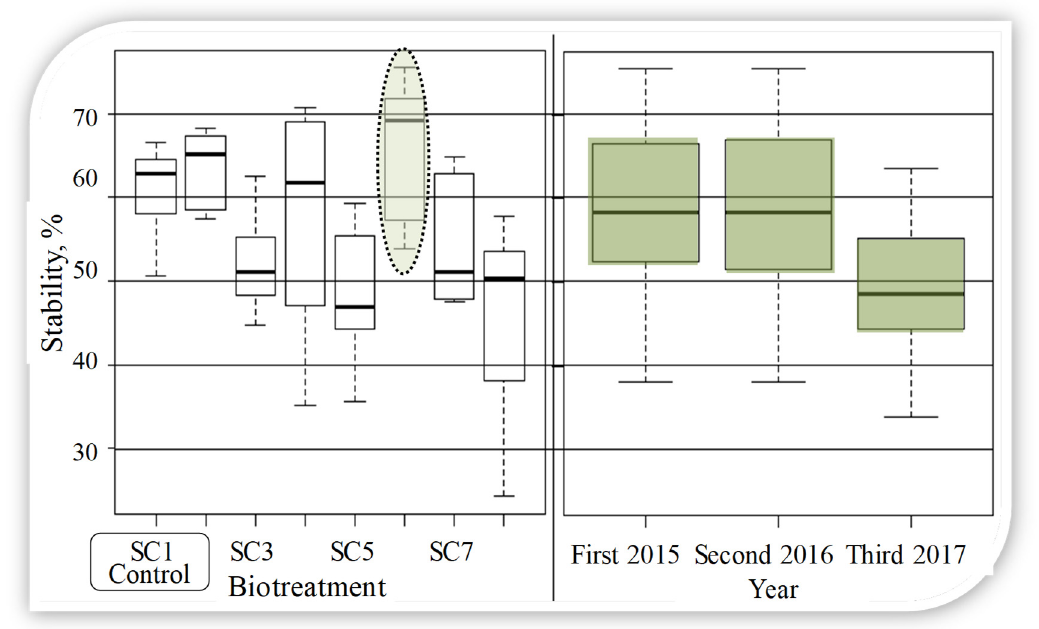
Figure 9. Stability (%) dependence on bio-impact(s) time (year) and scenario.